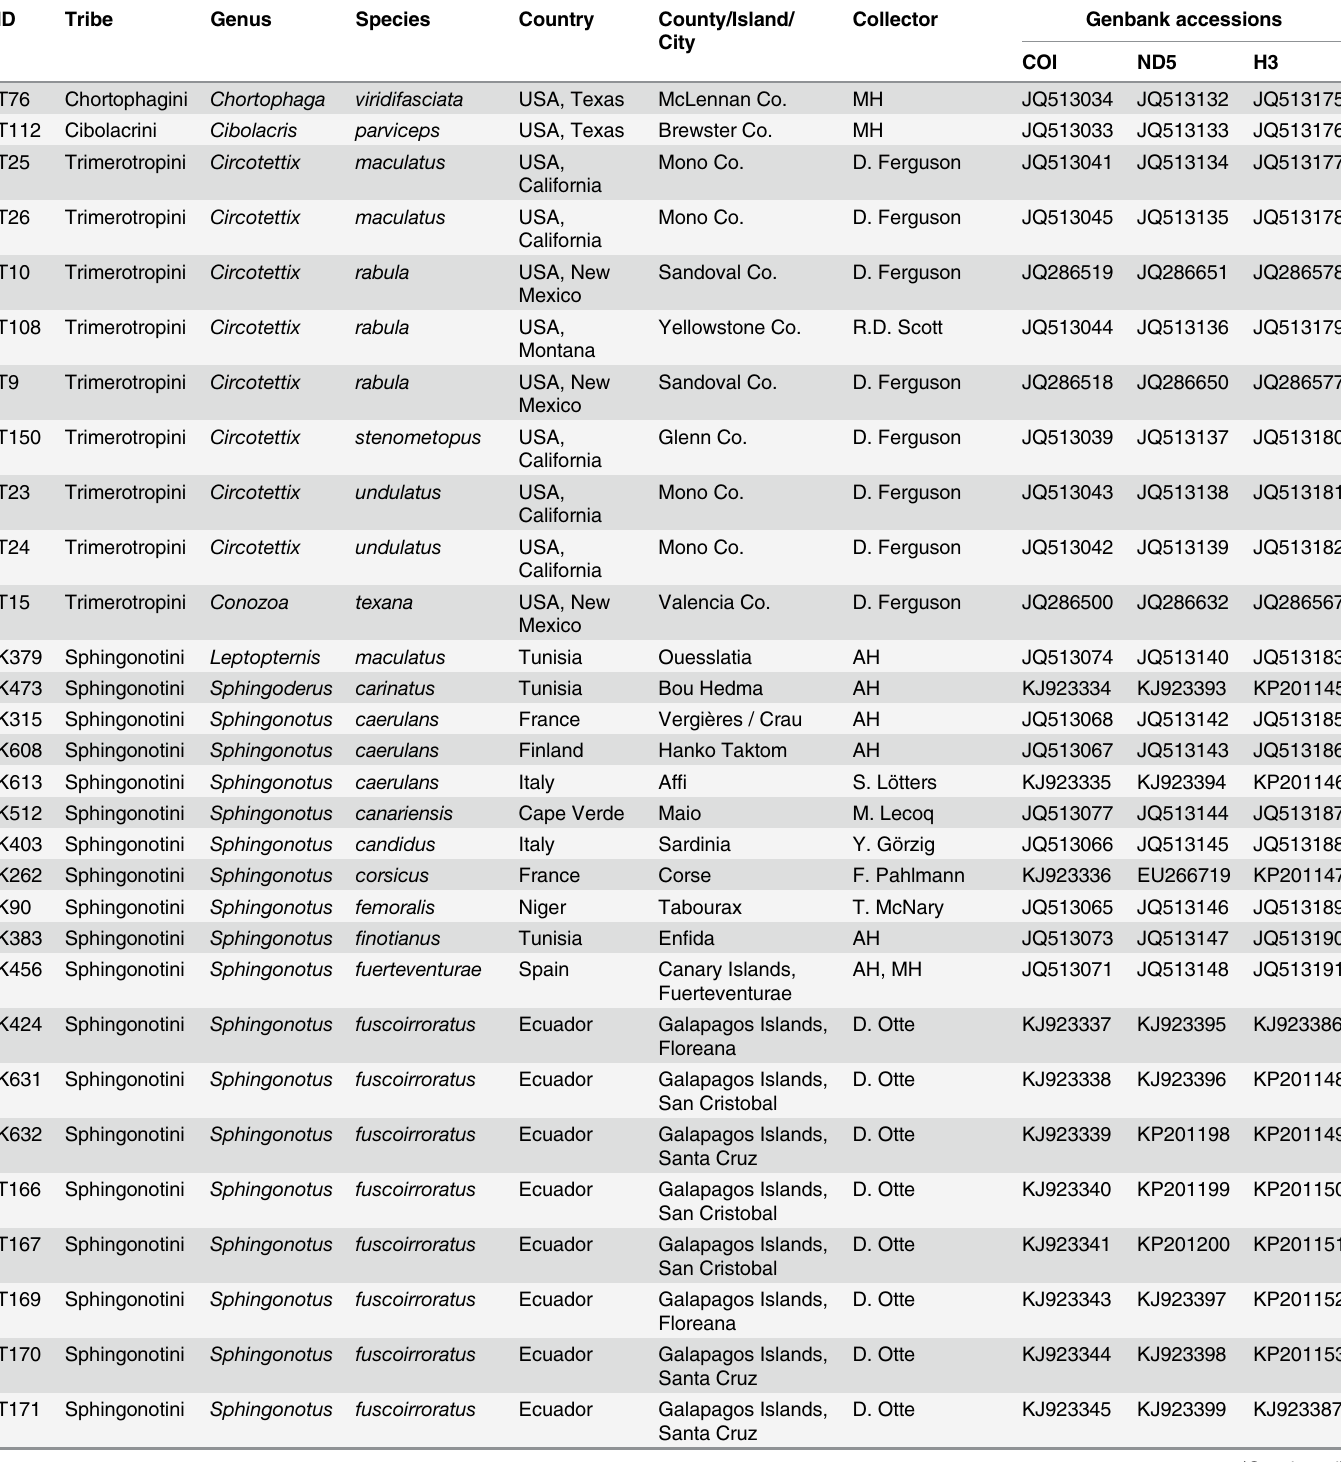
Table 1. Overview of all samples used for molecular analyses; given are sampling location, GPS-coordinates, date of sampling and respective Genbank accession numbers.